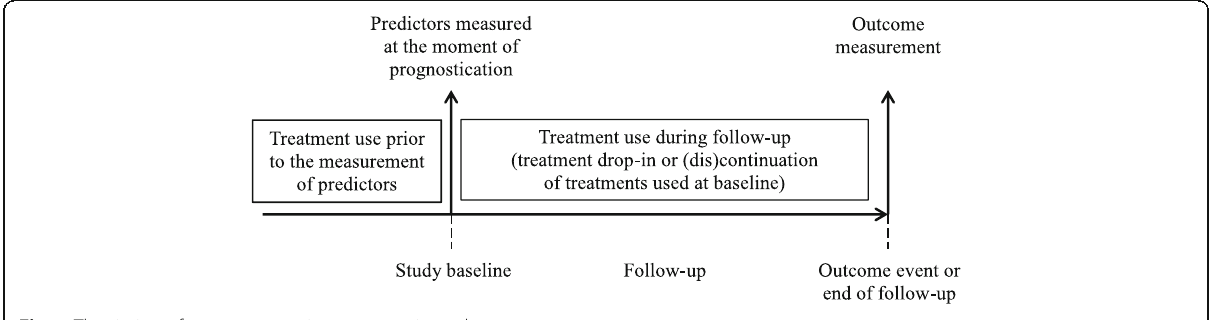
Fig. 1 The timing of treatment use in a prognostic